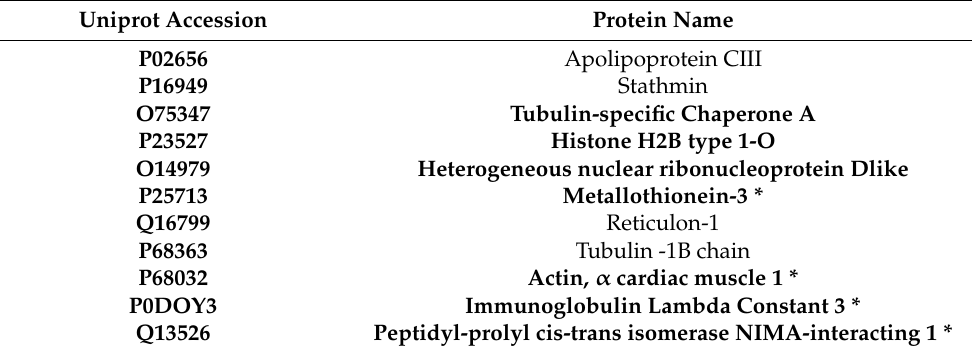
Table 3. Protein elements shared between CUSA CORE and CUSA